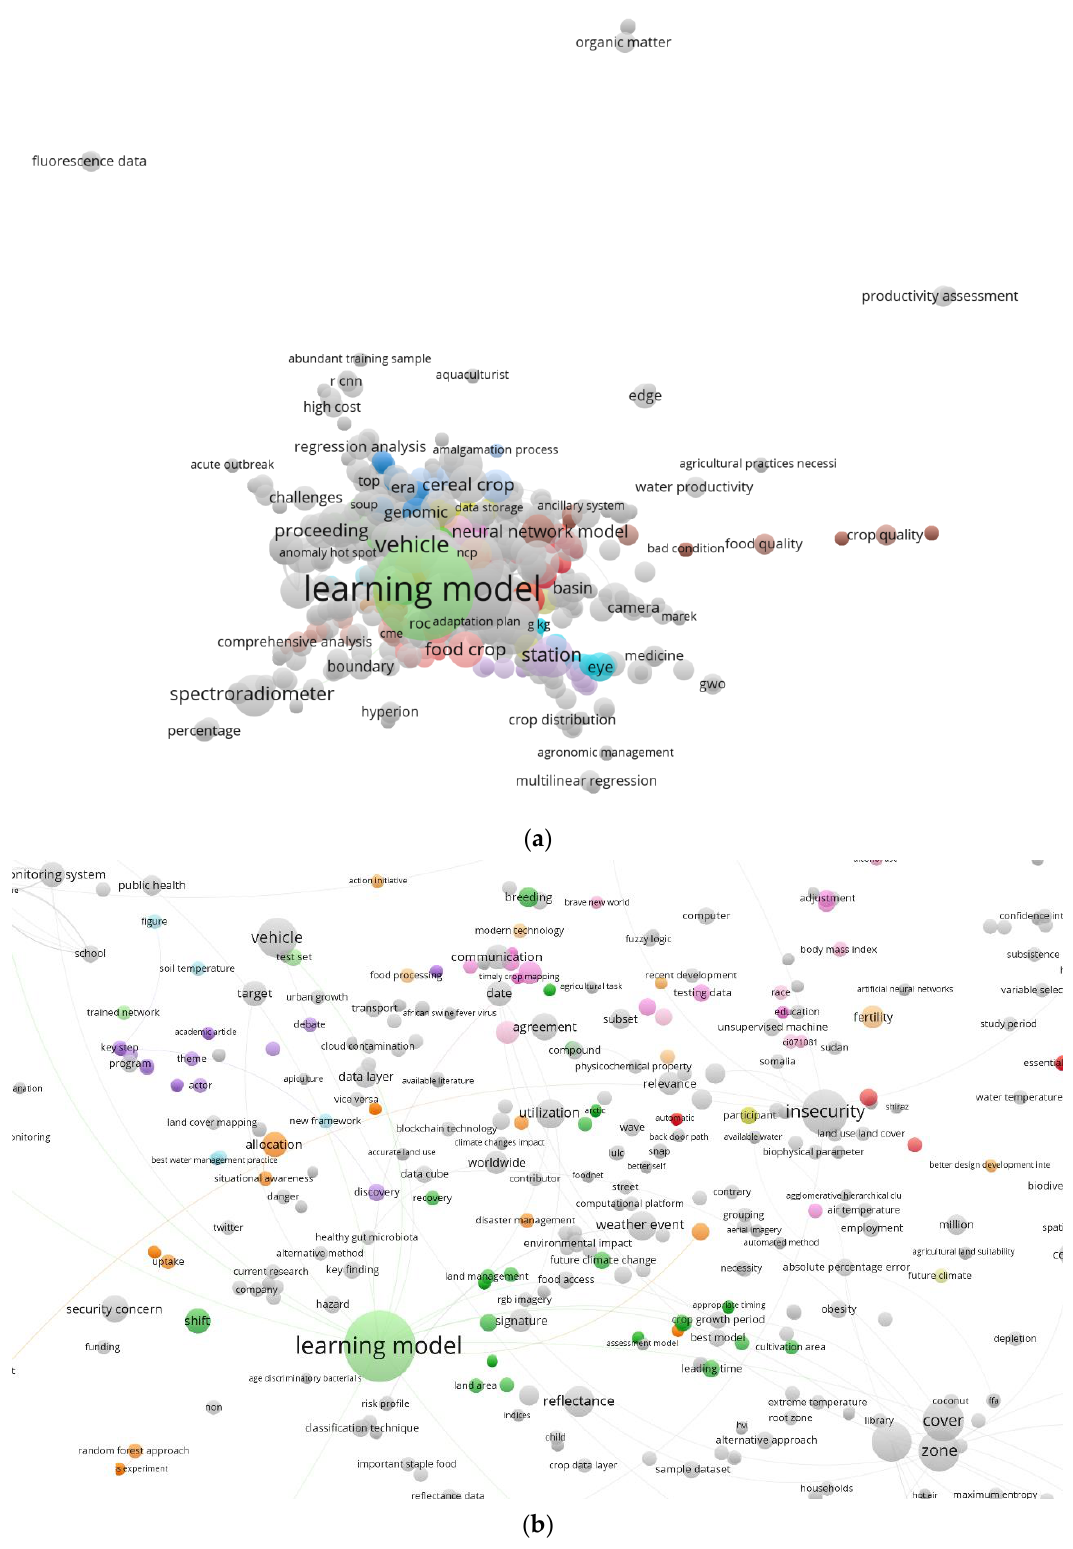
Figure 1. Network visualization map for text data (co-occurrence links and terms as items), consid- ering binary counting and 1 as the minimum number of occurrences of a term. ( a ) Full network; ( b ) network around the items with the highest